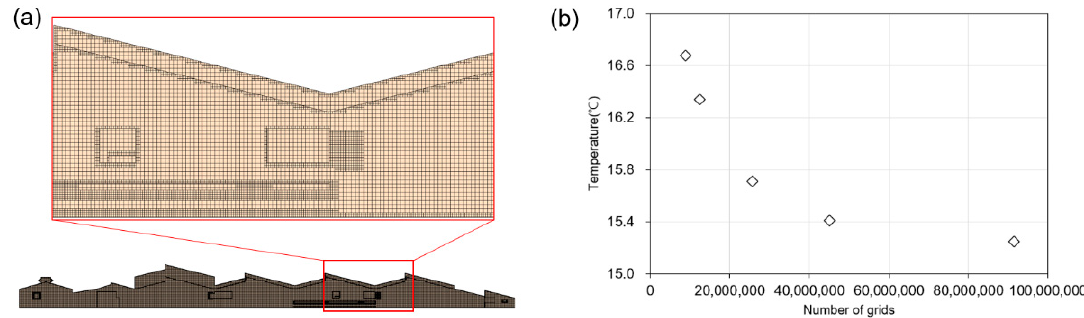
Figure 4. ( a ) Grids of the computational domain; ( b ) grid dependency test results.